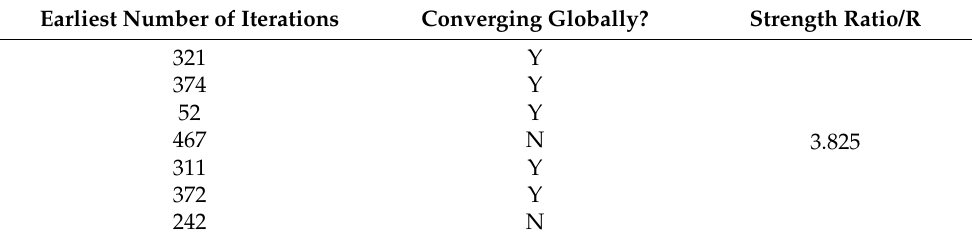
Table 3. Calculation data for searching for the optimal solution.